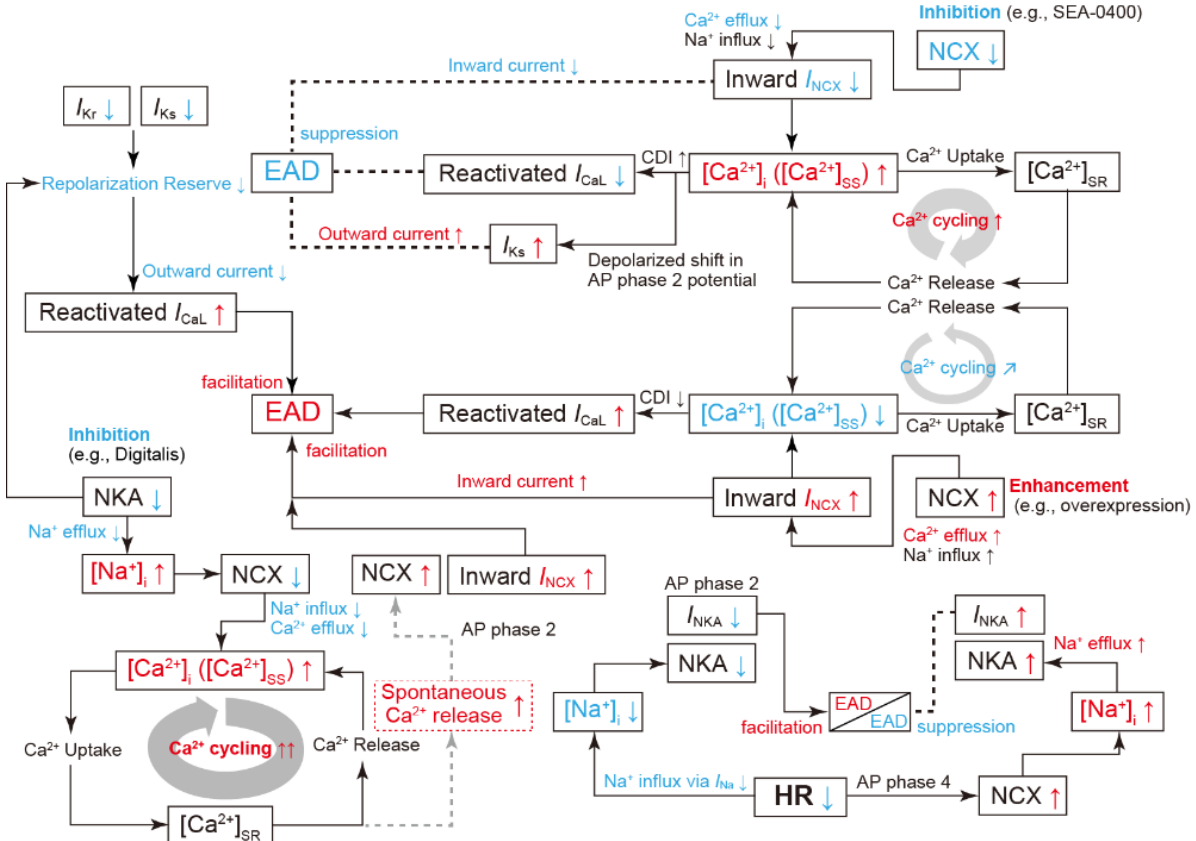
Figure 3. Schematic diagram showing how the dynamics of individual ion channels, transporters, [Ca 2+ ] I , and [Na + ] i contribute to EAD generation and regulation. The diagram depicts the major functional components ( I Ks , I Kr , I CaL , I NCX , and I NKA ), factors involved in Ca 2+ - and Na + -handling, heart rate (HR), and their interactions related to EAD generation and regulation. The upward and downward arrows represent an increase (or enhancements) and decrease (or attenuations) in each factor, respectively. A decrease in HR (bradycardia) decreases Na + influx via the Na + channel activation, resulting in a decrease in [Na + ] i . This reduction in [Na + ] i facilitates EAD generation through a decrease in outward I NKA during AP phase 2. On the other hand, a decrease in HR prolongs AP phase 4, i.e., diastolic interval (DI), and the prolongation of DI increases the amount of Na + influx through NCX and thus causes [Na + ] i elevation. This [Na + ] i elevation increases Na + efflux through NAK and outward I NAK during AP phase 2. This may counteract the decrease in [Na + ] i due to reduced I Na and the resulting reduction in I NKA (modified from Figure 11 in [85]). For details of other depicted interactions that affect EAD formation, see text.